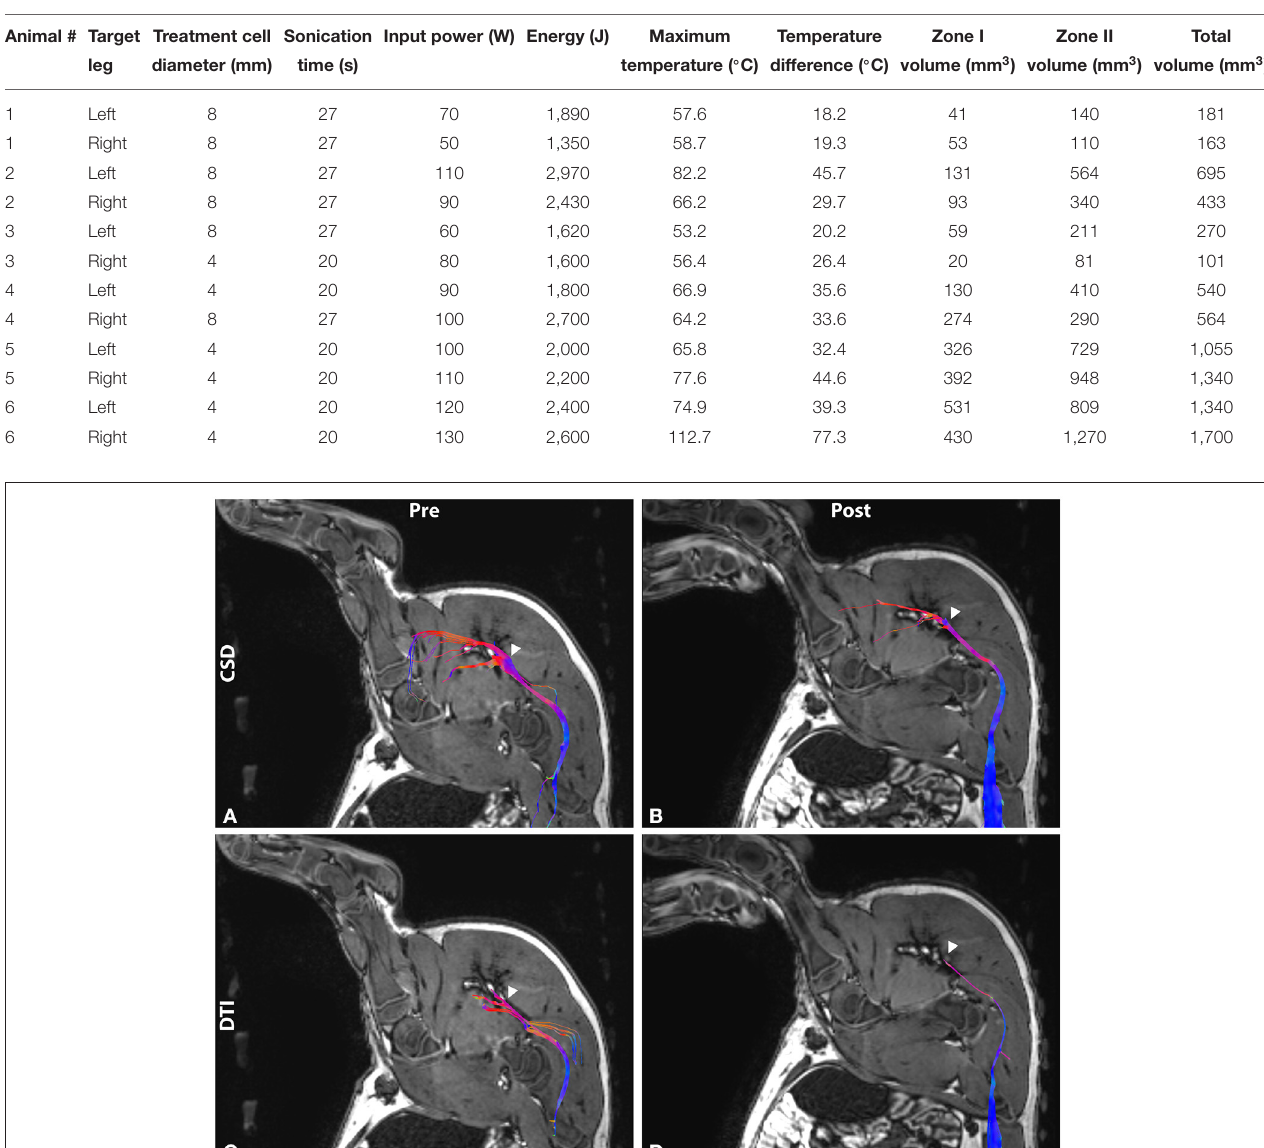
TABLE 1 | MR-guided focused ultrasound treatment parameters.